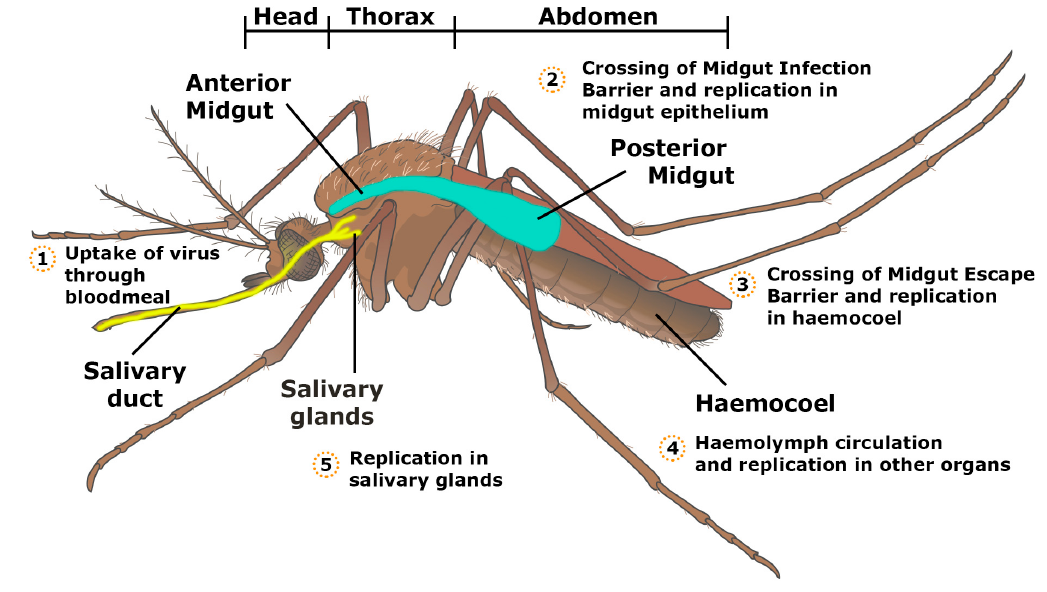
Figure 2. Schematic representation of the locations of virus replication in the mosquito.